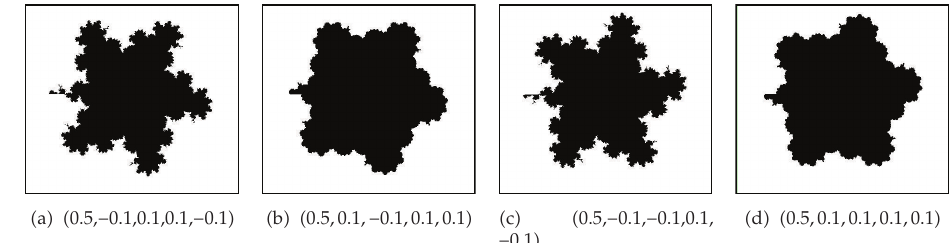
Figure 24: The generalized J sets perturbed by the composing noise when α (cid:6) 5 . 5, θ ∈ (cid:7) − π,π (cid:4) , here Figures